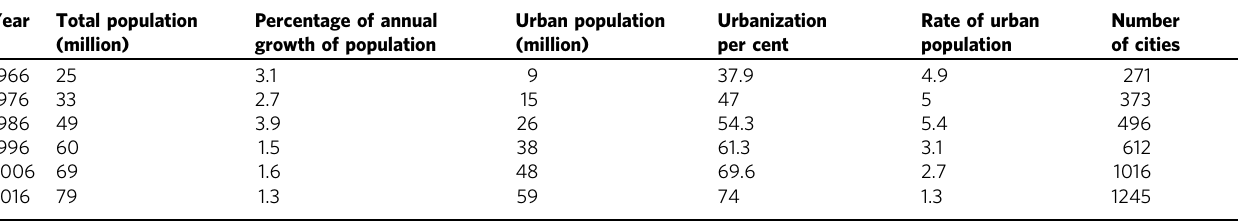
Table 2 Number of cities, urbanization percent and urbanization rate in Iran (1966 – 2016).